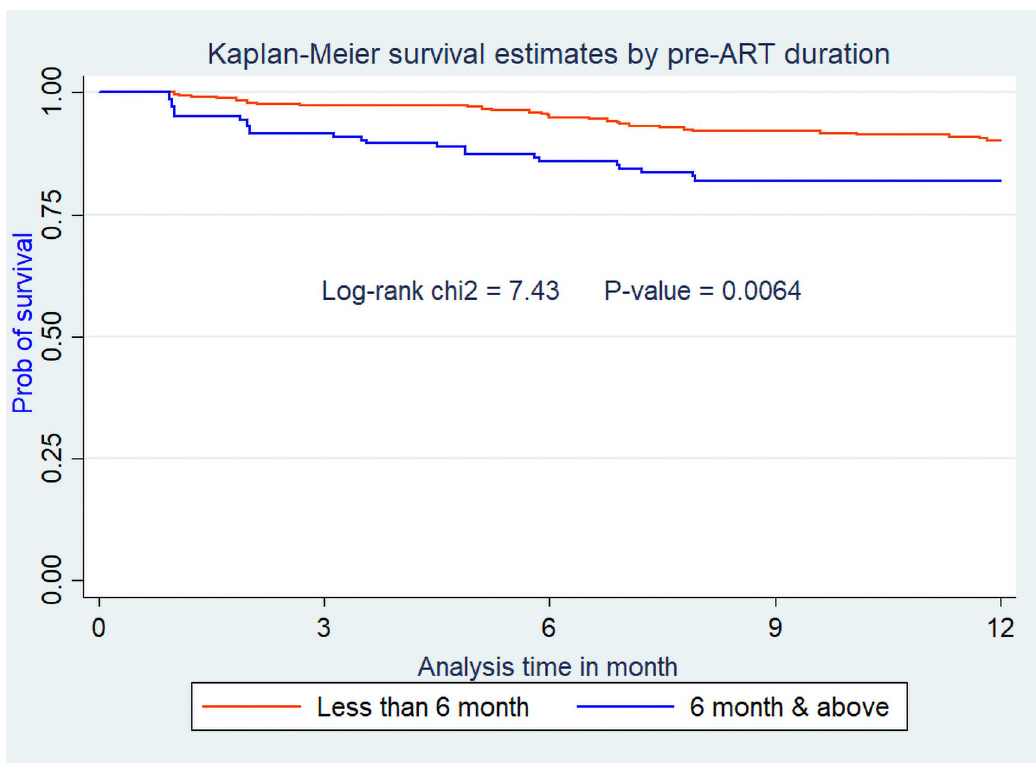
Fig 3. Kaplan Meier survival curve from ART initiation to death within one year stratified by pre-ART duration among adults on ART at Debre-Markos Referral Hospital from Jan 1, 2014, to Dec 31, 2018.